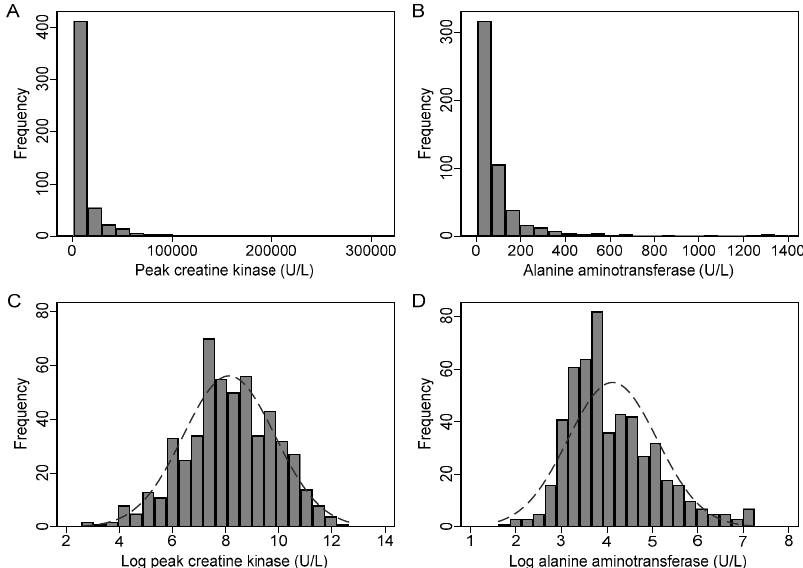
Figure 2. E ff ect of logarithmic transformation on the distribution of peak CK and ALT. Histograms demonstrate the distribution of the raw peak CK ( A ) and raw ALT ( B ), and the distribution after logarithmic transformation with a superimposed normal distribution curve for CK ( C ) and ALT ( D ).